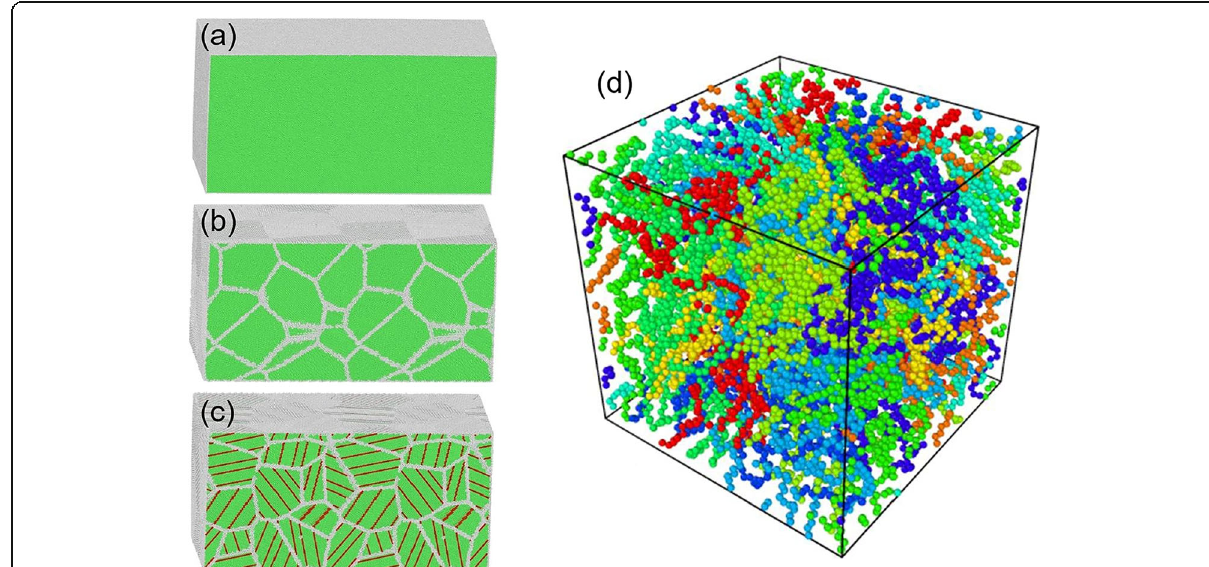
Fig.1 a Microstructure of single crystal Cu. b Microstructure of nanopolycrystalline. c Microstructure of NT polycrystalline. Atoms are colored according to CNA values, as green and white stand for FCC and defect atoms [25]. d The equilibrated united-atom model of amorphous PE, the model was colored by different molecular chains